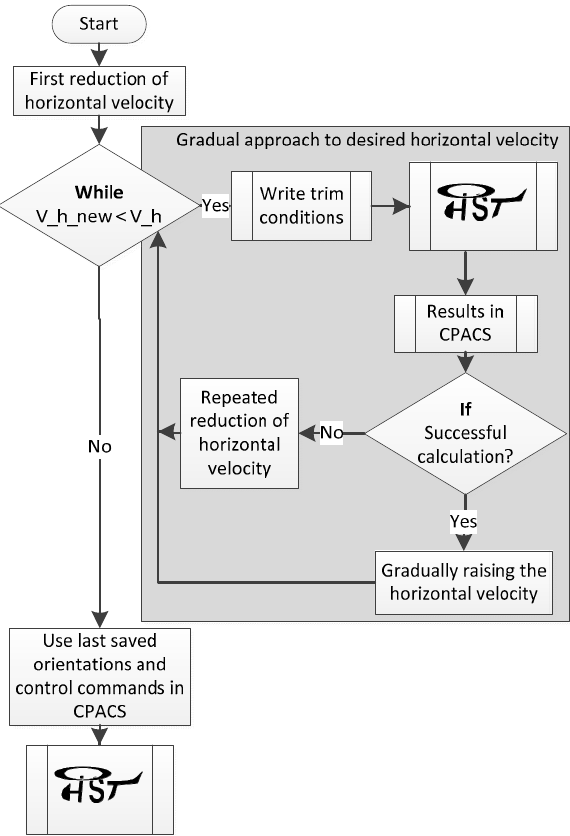
Figure 11. Process for high velocity trim calculations with HOST.